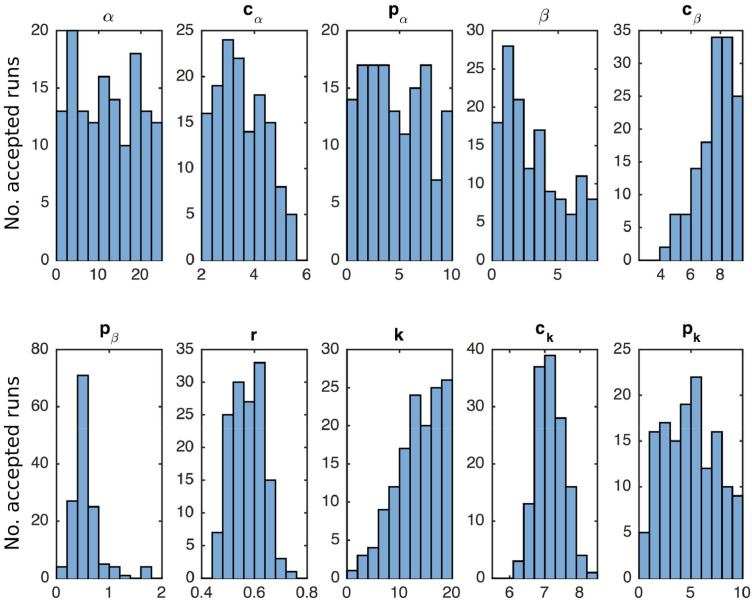
Posterior distributions for parameters in (4), (5), (6), (7), (8) from Approximate Bayesian Computation, with a sum of squares error threshold of 9 after 100,000 model runs. For each parameter 10 equally sized bins between the minimum and maximum of the uniform priors are used.